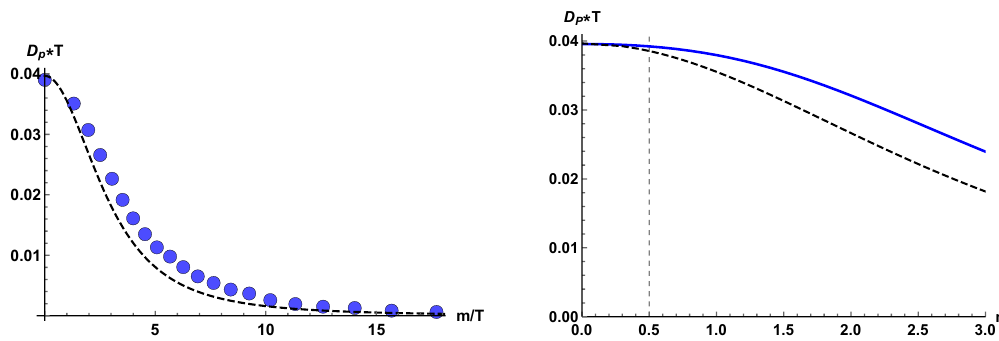
Figure 6 . Left: the longitudinal phonons’ di(cid:11)usion constant D p as a function of the dimensionless parameter m=T for V ( X ) = X 3 . Right: the comparison between the numerical data (solid line) and the theoretical expectations for m=T (cid:28)